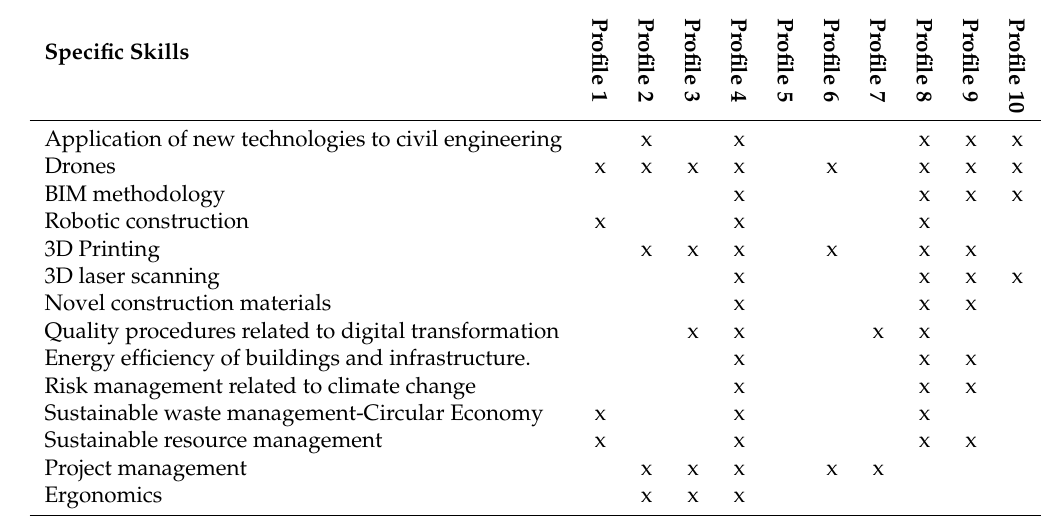
Table 4. Near-future skills for each profile: Specific